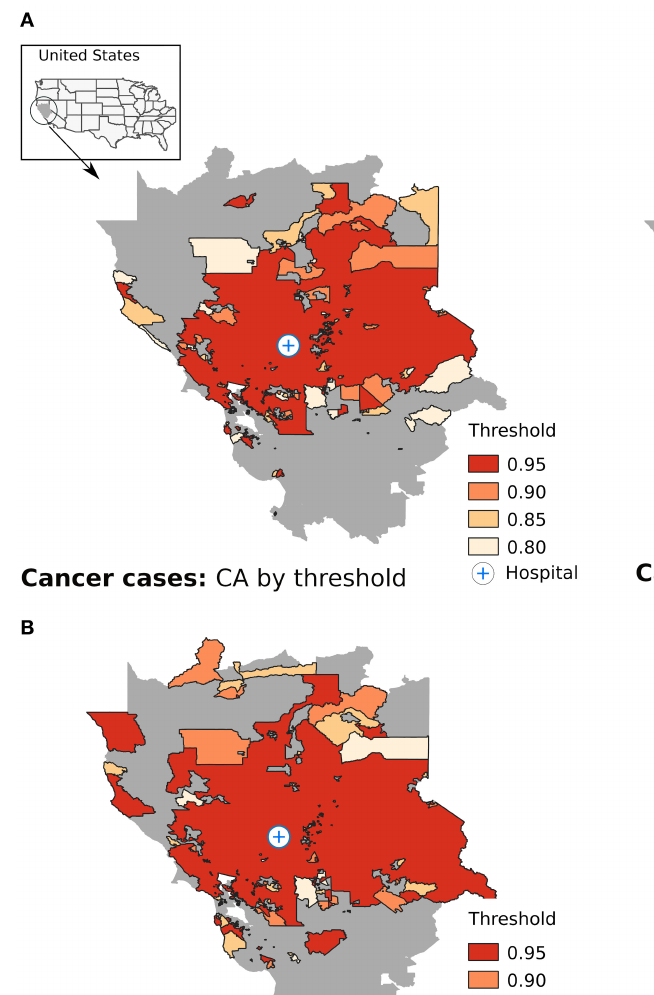
respectively, and represented only a small increase in the CA compared to the solution at 0.90 ( Figure 1